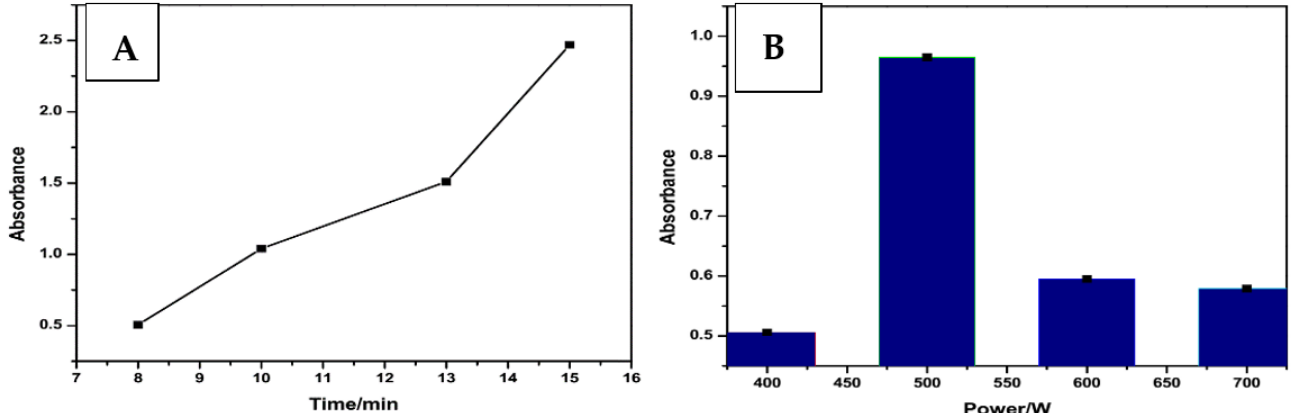
Figure 2. Graphical representation for monitoring the intensity of azomethine bond of the BPND ligand after microwave synthesis based on the time variation of 8, 10, 13, and 15 min at a constant microwave power of 400 W ( A ) and power variation of 400, 500, 600, and 700 W for both 8 and 13 min ( B